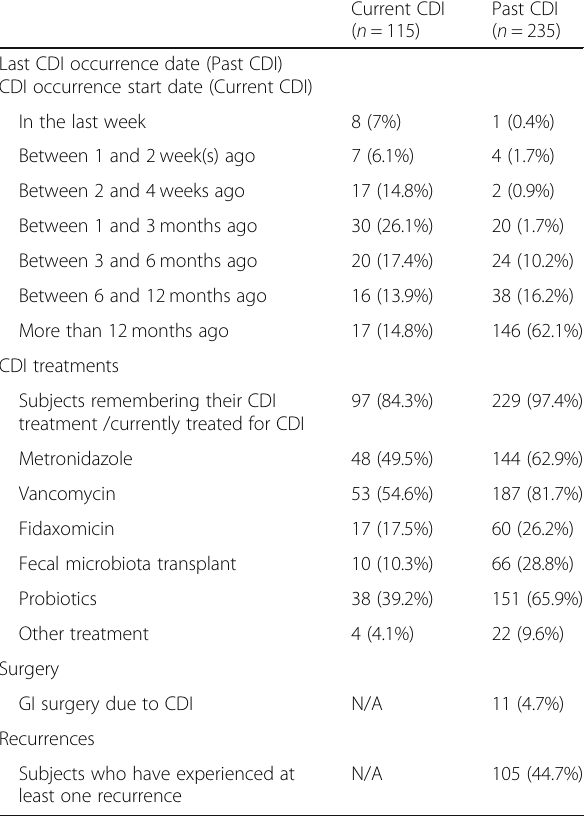
Table 1 Characteristics of survey participants (CDI: Clostridioides difficile infection)